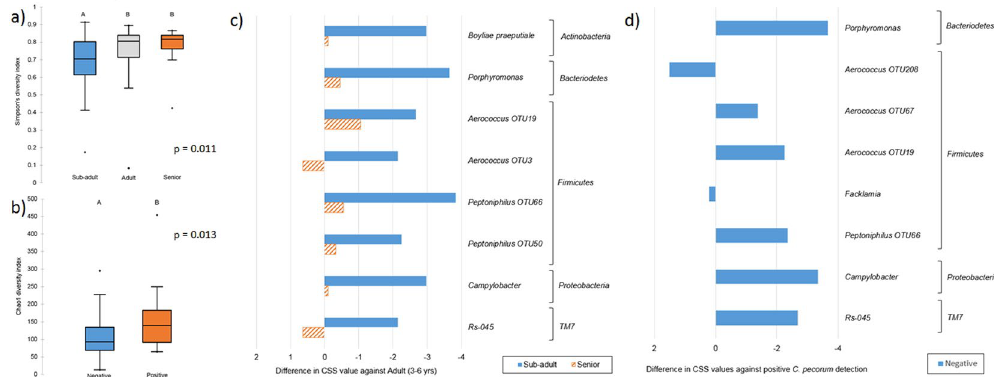
Figure 4. Comparative analysis of influence of biological variables on male koala penile microbiota for alpha- diversity and OTUs, with statistical significance (p < 0.05) as inferred by Kruskal-Wallis test. Box-plot of Chao1 diversity metric for ( a ) age, and ( b ) C . pecorum infection status-2. Bargraph of differences in OTUs values that have been normalised by CSS for ( c ) age, and ( d ) C . pecorum infection